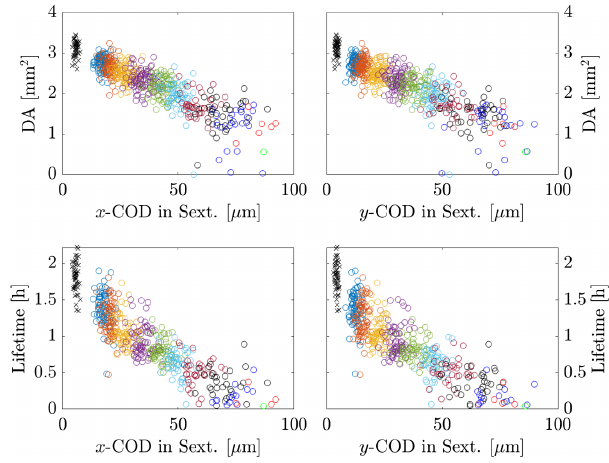
FIG. 8. Scatter plots of DA (top) and Touschek lifetime (bottom) vs rms closed-orbit distortion (COD) in the chromatic sextupole magnets. Left and right plots show the horizontal and vertical CODs, respectively. DA and lifetime are calculated after performing LOCO-based linear optics correction (see Secs. IVA – IV H) for various sets of BBA accuracy assumptions between 0 and 100 μ m identified by colored circles. The black crosses are calculated with 0 - μ m BBA accuracy and 10 μ m magnet and girder offsets. Each data point corresponds to one lattice and appears in all four plots. The average lifetime is below the 0.5 h requirement above 60 μ m COD. Note that only cases where LOCO converged are shown (see also Fig. 6).